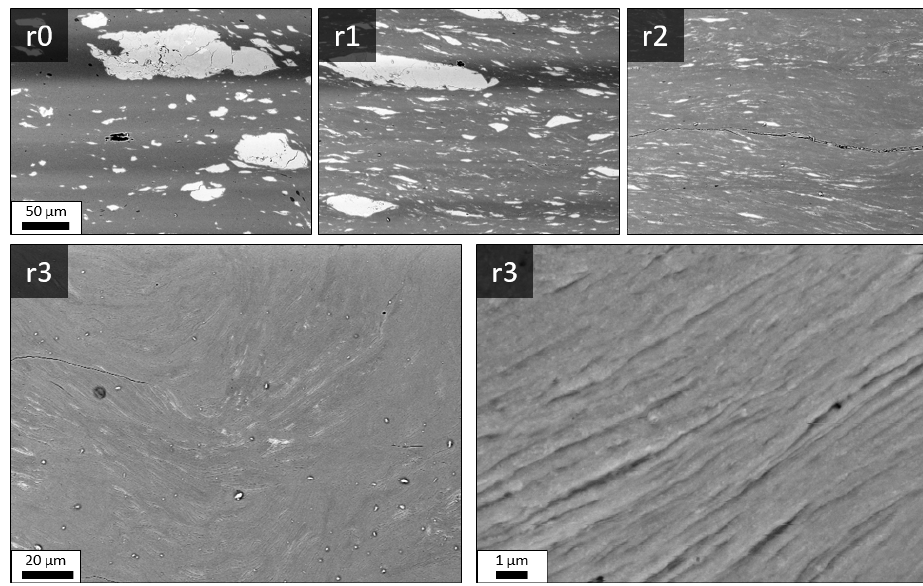
Figure A3. BSE images of a HPT-deformed sample (Nr. 4) at RT consisting of 87 wt.% Fe–13 wt.% SmCo 5 at different radii. The scale bar in r0 also applies to r1 and r2. Images of two magnifications are presented for